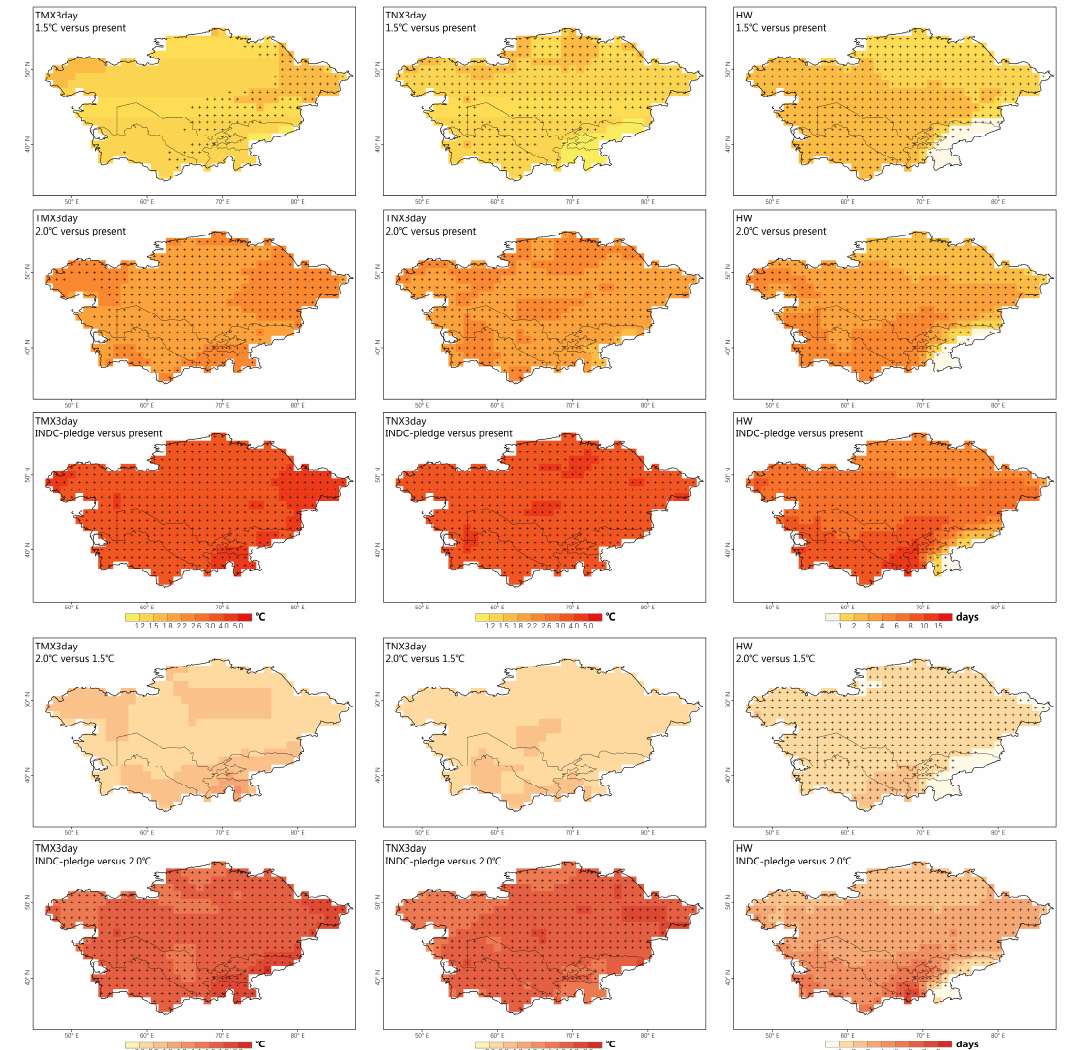
Figure 4. Changes in TMX3day (column I), TNX3day (column II), and HW (column III) over Central Asia, based on the multi-model ensemble mean. The differences between different sets of scenarios are displayed in the top-left corner. The dotted areas are statistically significant at the 5% level according to Wilcoxon’s rank-sum test.